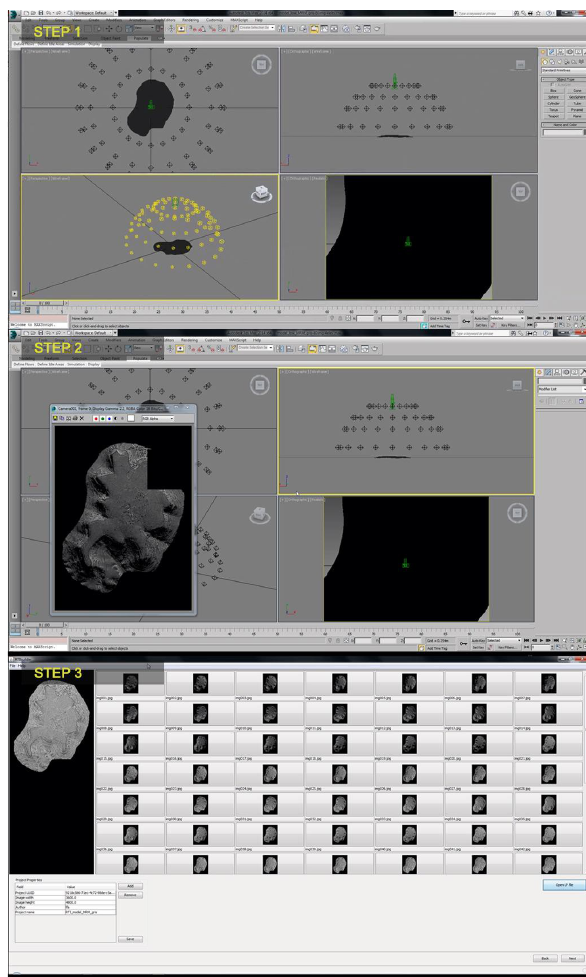
Figure 4: V-PTM processing pipeline (from top): Virtual light dome; image capture using rendering filters; assemblage of PTM using RTI Builder to process the virtual photographs (video available at: http://youtu.be/-QjSMeumSjE ).